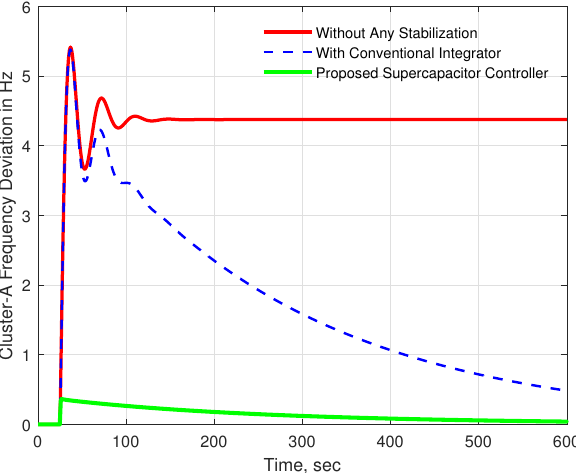
Figure 8. Frequency response for cluster A with 0.15 p.u. disturbance in cluster A. The frequency response of cluster B was significantly improved with the proposed supercapacitor method compared to the other approaches as well (Figure 9).